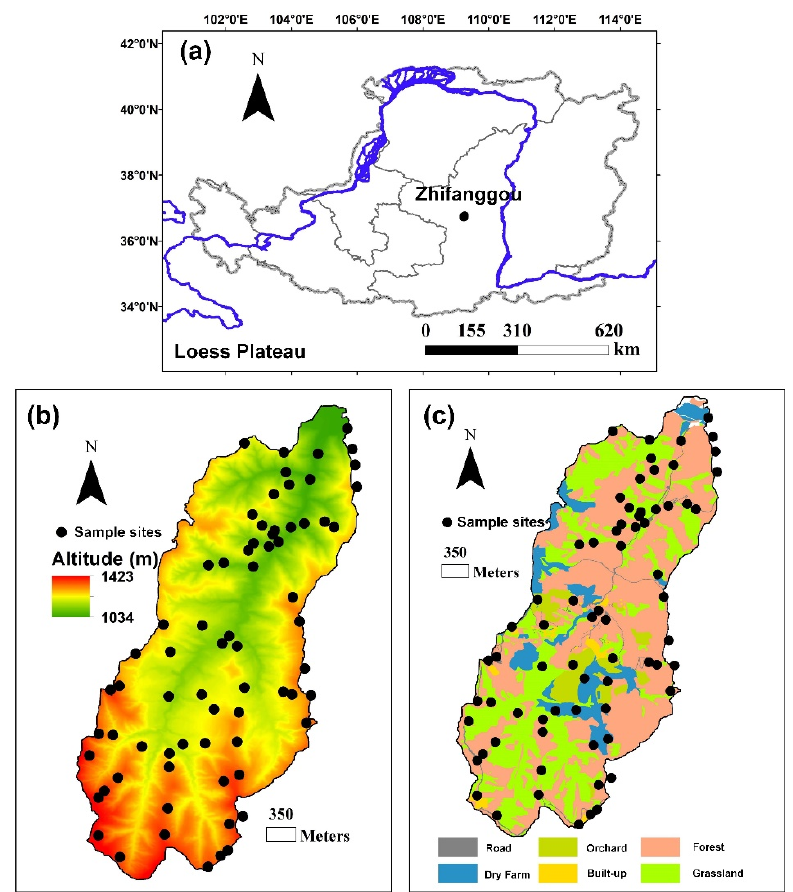
Figure 1. Location of the Zhifanggou watershed in the Loess Plateau region ( a ), the sample sites and an altitude of the catchment ( b ), and the land use type in the catchment ( c ).